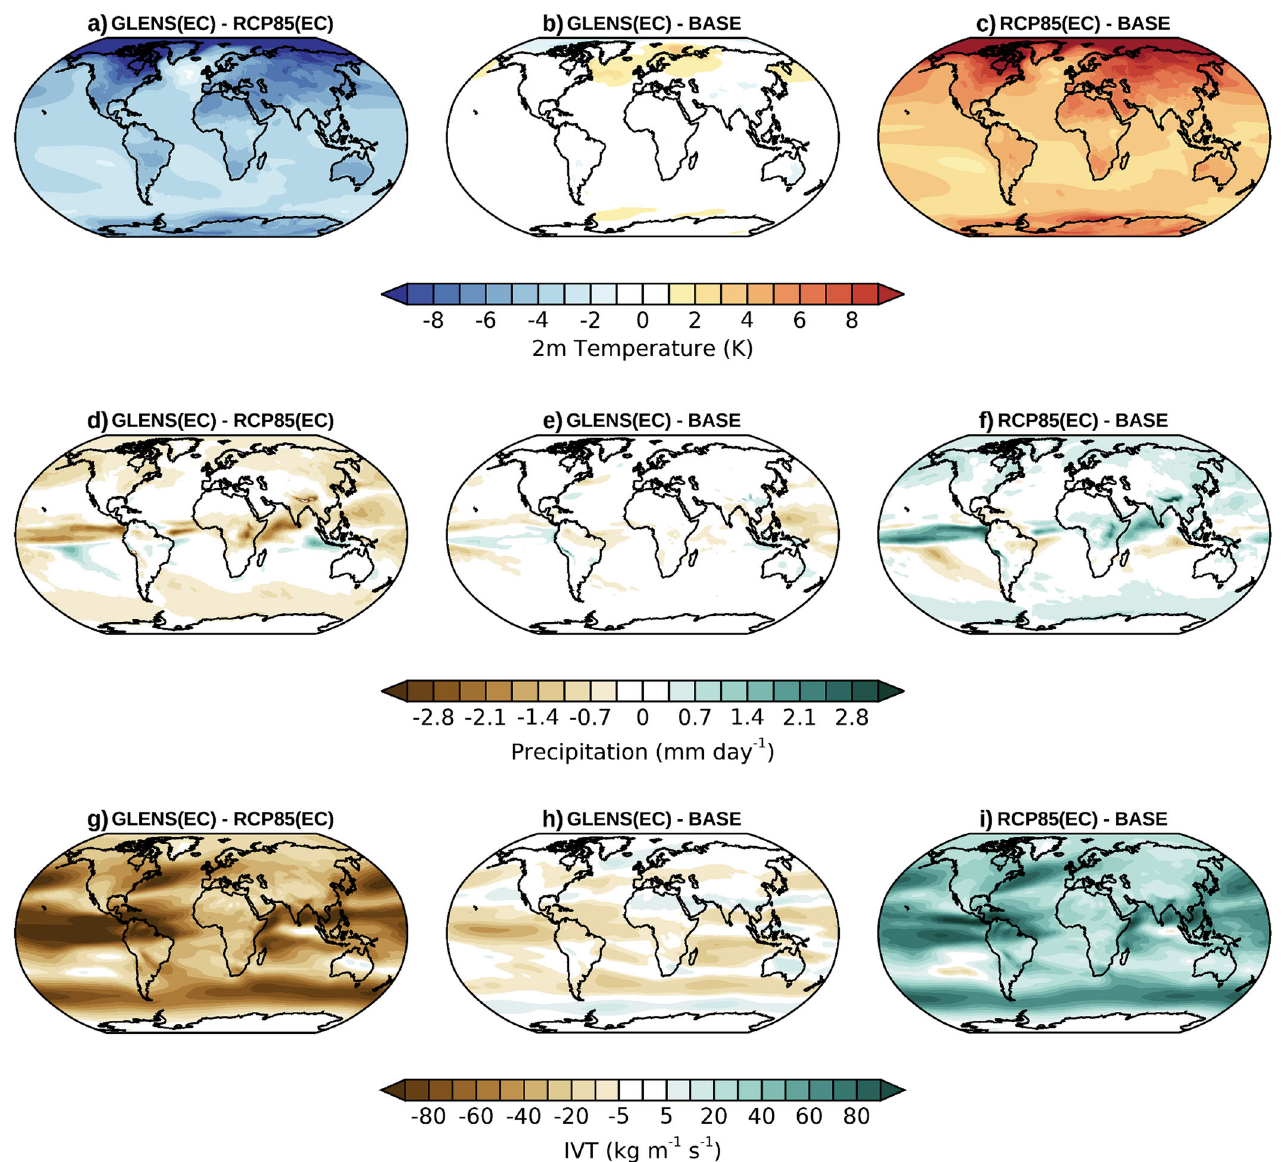
Fig. 1 Background climate for analysis scenarios. Annually averaged surface air temperature ( a – c ), total precipitation ( d – f ), and integrated vapor transport ( g – i ) differences for the three analysis periods (GLENS - RCP8.5, end of century (EC) a , d , g ; GLENS - RCP8.5, EC and BASE ( b , e , h ), respectively; RCP8.5, EC - BASE, c , f , i ). Surface temperature is in °C, precipitation is in mm day − 1 , and integrated vapor transport is in kgm − 1 s − 1